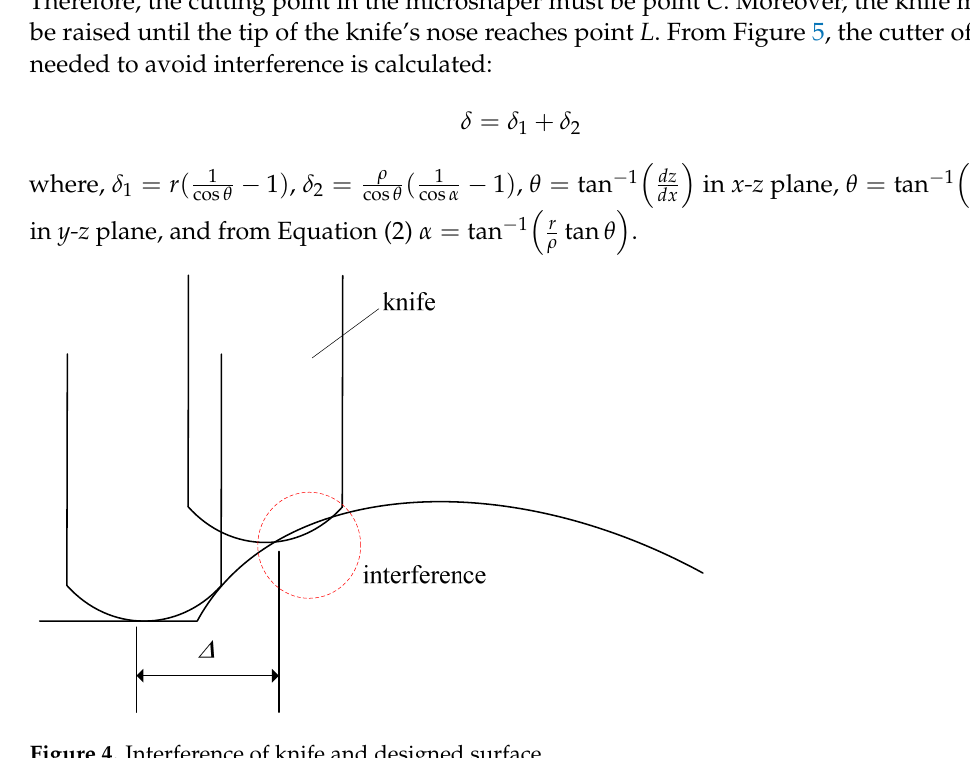
Figure 4. Interference of knife and designed surface.